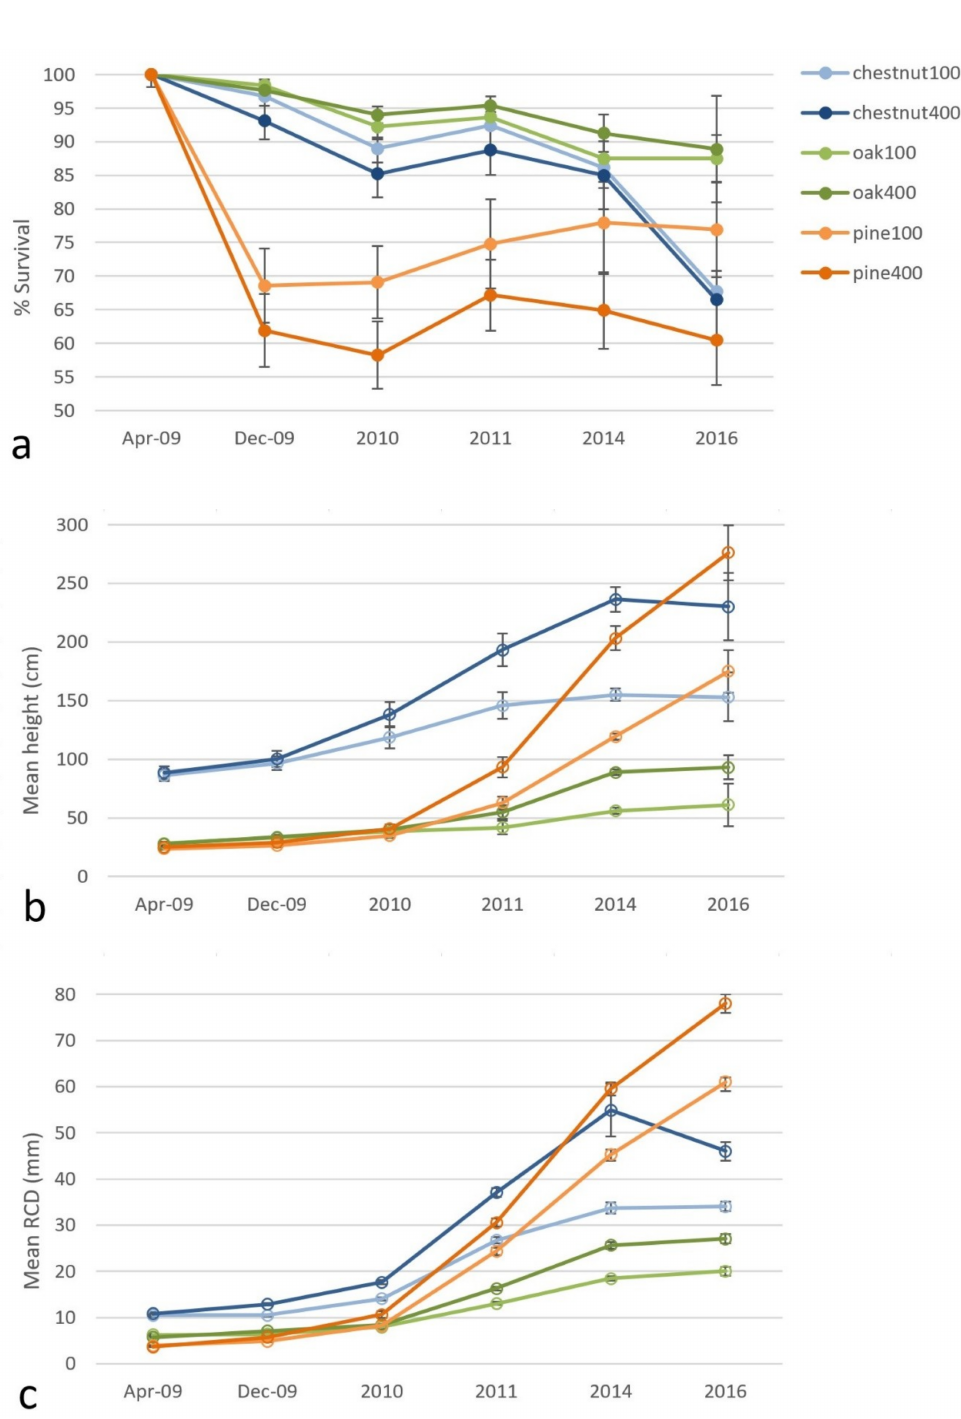
Figure 3. Shortleaf pine (orange), white oak (green) and American chestnut (blue) responses to fertilization at the rate of 400 kgN / ha or 100 kgN / ha. ( a ) survival; ( b ) mean height; ( c ) mean root collar diameter. Bars indicate standard